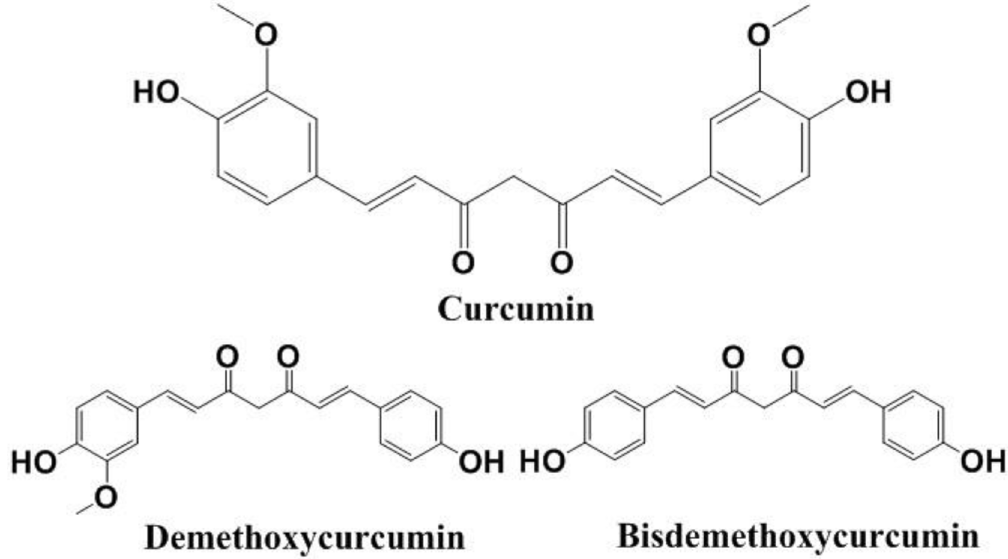
Figure 1. Chemical structures of curcuminoids.